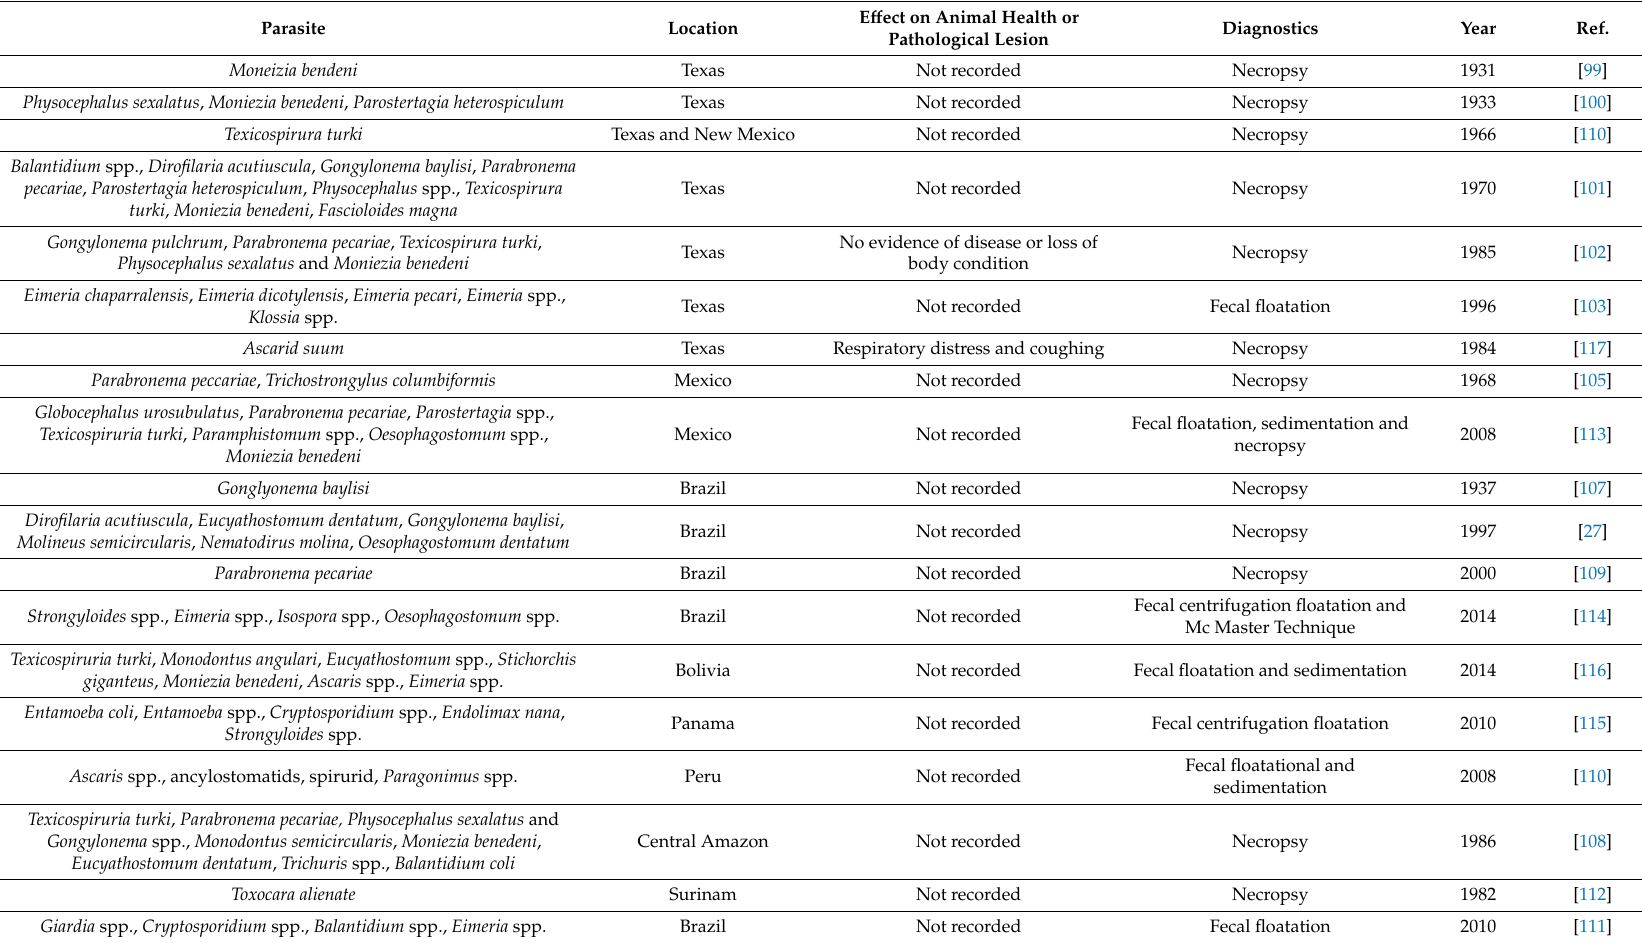
Table 5. Endoparasites found in the collared peccary ( Tayassu tajacu ) at di ff erent